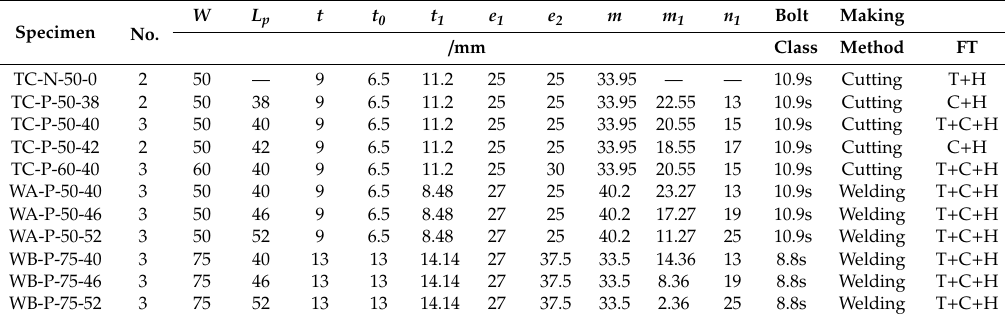
Table 1. Target controlling parameters in di ff erent specimens of the